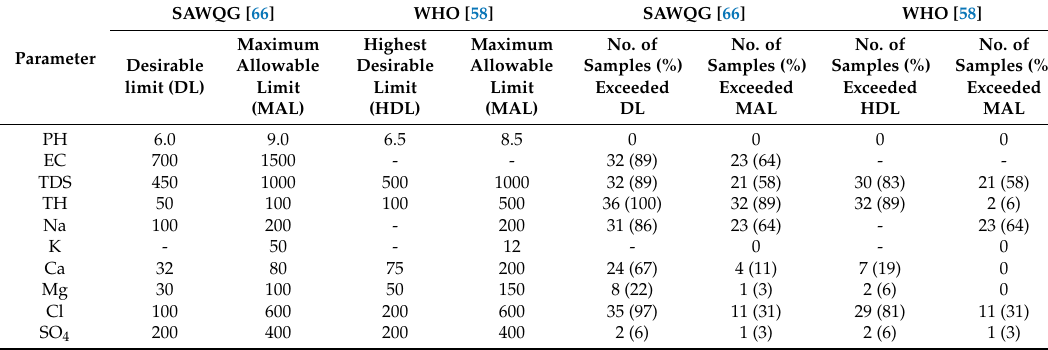
Table 4. Groundwater suitability